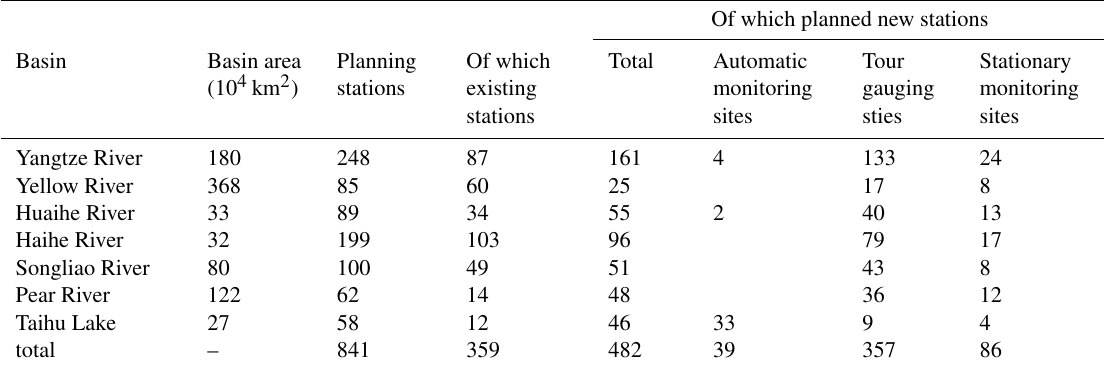
Stationary Tour monitoring gauging sites sties